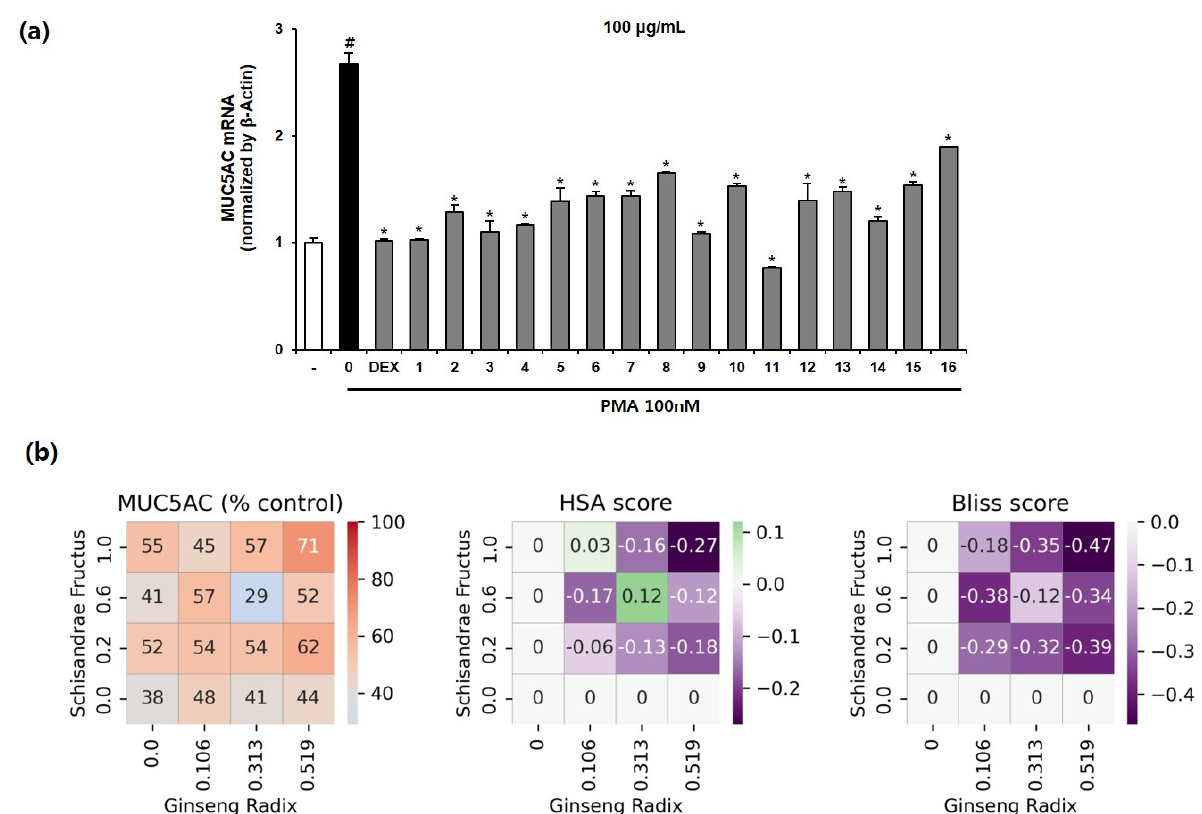
Figure 6. Effects of the 16 multi-herb ratio combinations (MHRCs) on the phorbol 12-myristate 13-acetate (PMA)-induced mRNA expression levels of MUC5AC in NCIH292 cells. ( a ) NCI-H292 cells were treated with 10 nM dexamethasone and 16 MHRCs (100 µ g/mL) for 1 h before exposure to 100 nM PMA for 24 h. The MUC5AC mRNA level was determined using qRT-PCR. The data are expressed as mean ± standard error of the mean (SEM) (n = 2). The numbers on the x -axis indicate the codes given for the individual combinations (Table 1). # p < 0.05 compared to the untreated group. * p < 0.05 compared to the PMA-treated group. DEX, dexamethasone; PMA, phorbol-12-myristate-13- acetate. ( b ) Percent of the test group relative to the negative control, HSA score, and Bliss score for MUC5AC mRNA expression. The x -axis and y -axis represent the dose of drug C or drug D in each cell, and each cell represents one drug combination formulated with the dose of the drug corresponding to the x - and y -axis. The red color indicates a value higher than that of the positive control. Similar to the interaction pattern observed between drugs SF and GR in the